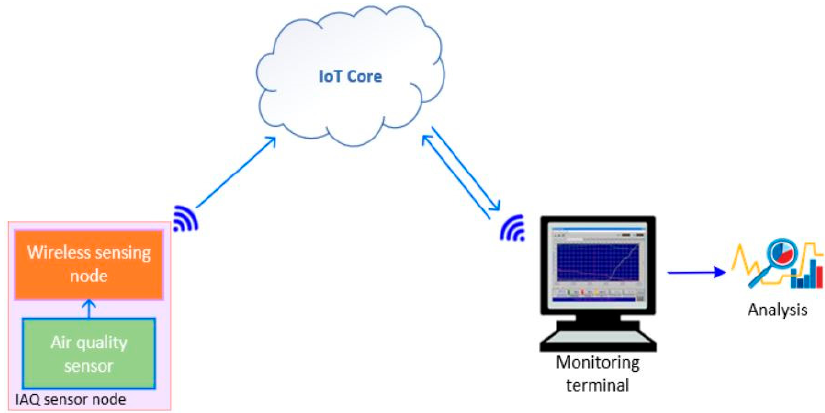
Figure 14. System configuration. Figure 14. System